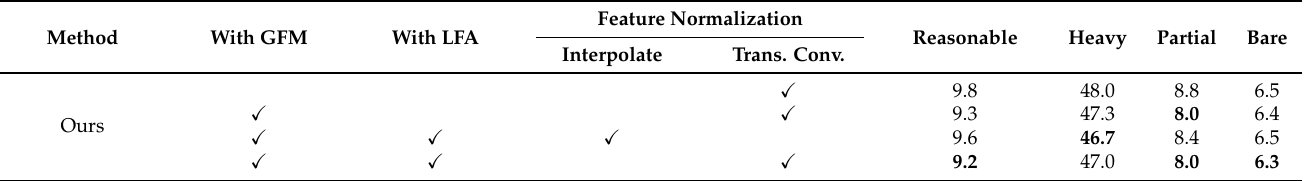
Table 5. The ablation studies of each component in the GFMA network. The best results are highlighted in